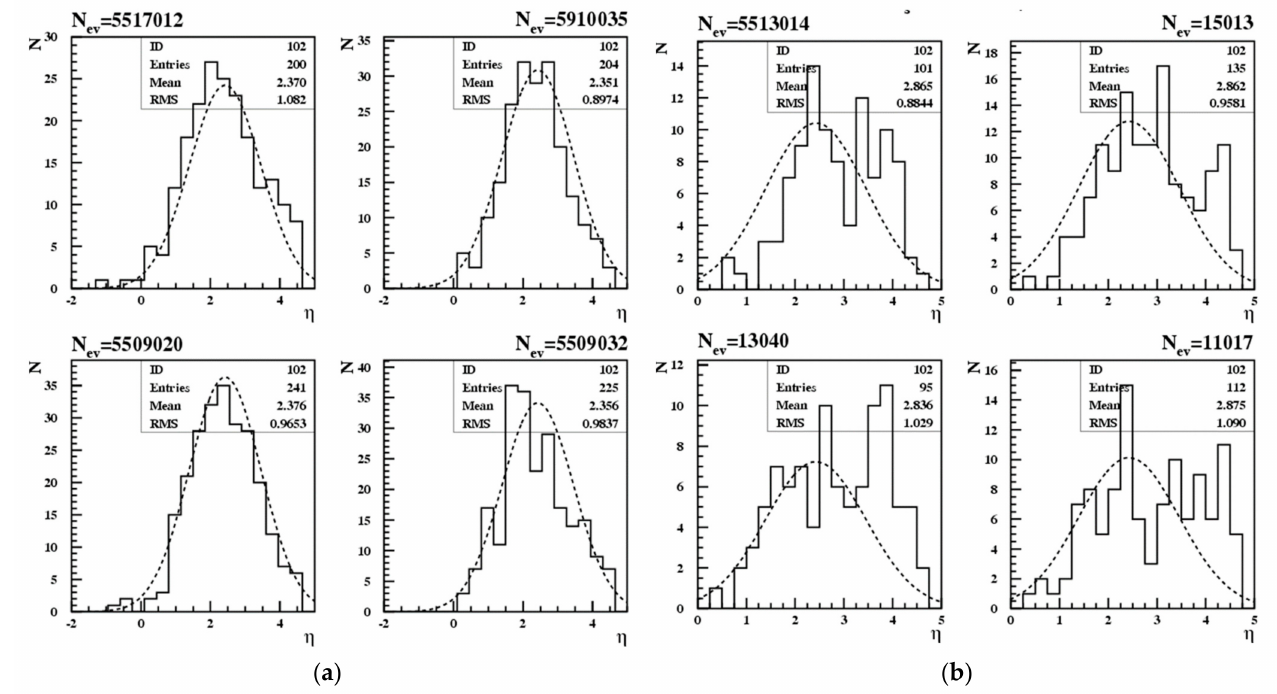
Figure 4. Pseudo-rapidity distribution of individual events Au + Em 10.6 AGeV with the mean pseudo-rapidity in the intervals: ( a ) from 2.3 to 2.4 and ( b ) from 2.8 to 2.9. Solid lines are experimental pseudo-rapidity distributions. Dashed lines are fit of the event N ev = 5517012 (normalized to the